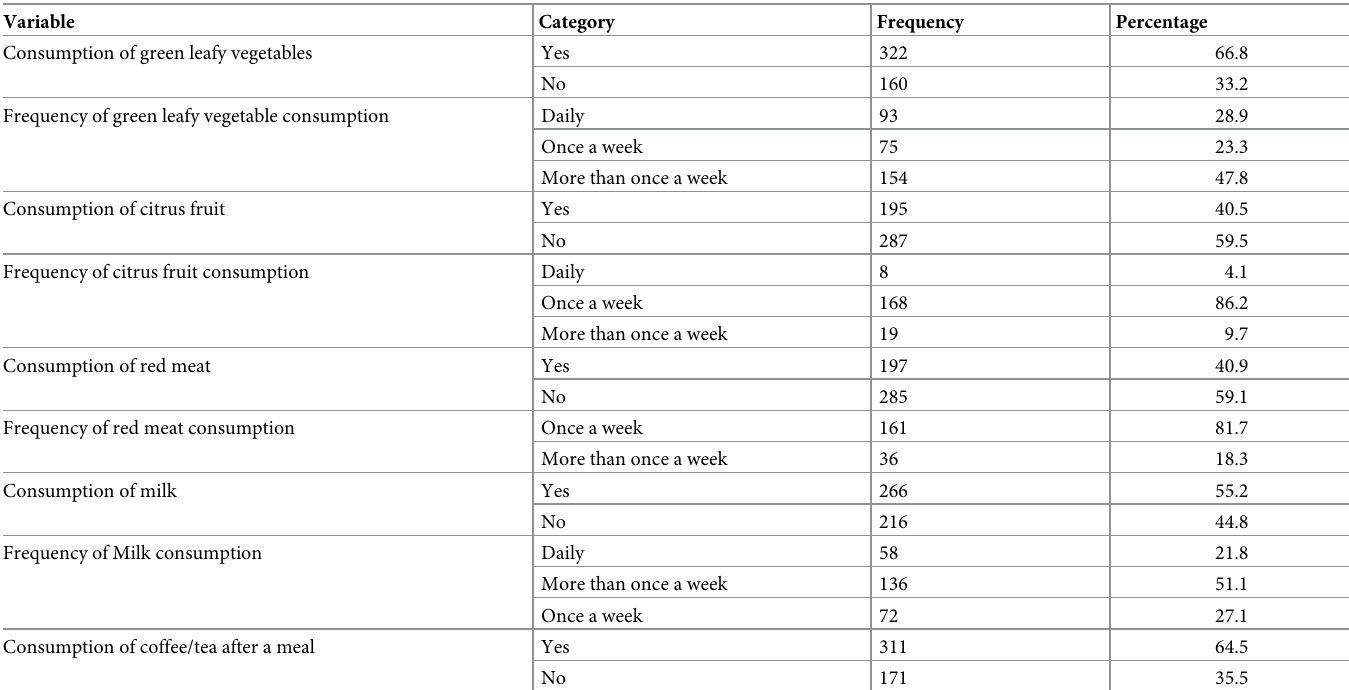
Table 2. Dietary factors of school-children in Kersa Woreda primary schools, eastern Ethiopia, 2020/21 (n = 482). Variable